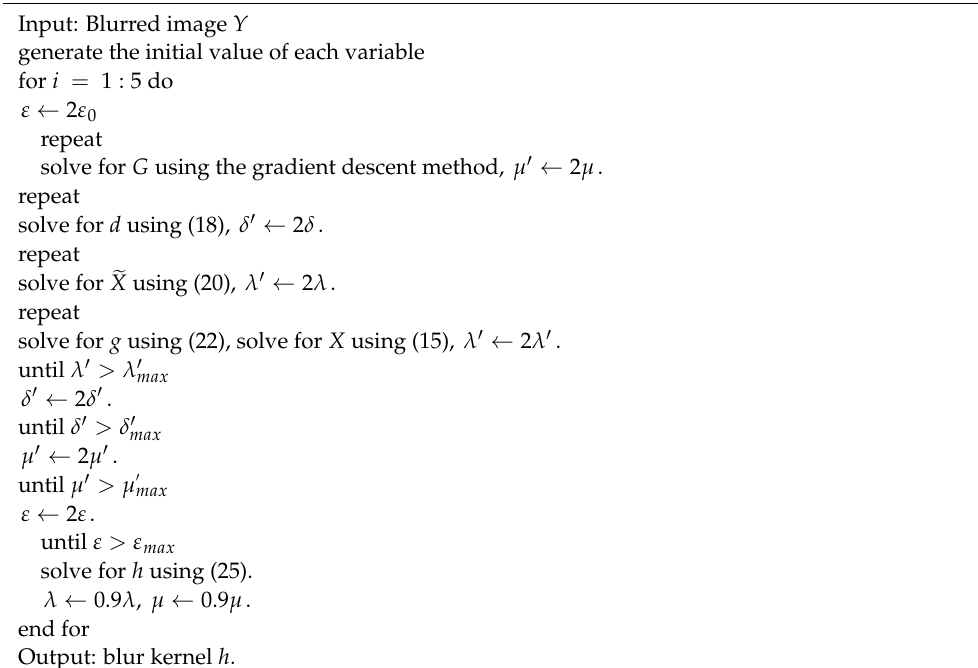
Algorithm 1: Blur Kernel Estimation